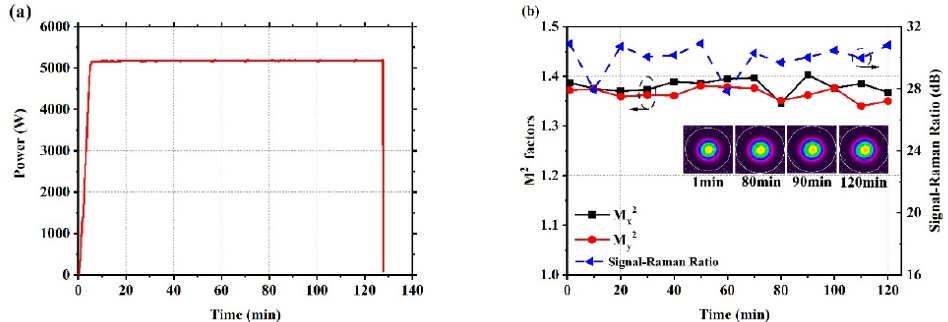
Figure 4. Output performance of stability test. ( a ) Output power. ( b ) M 2 factors with beam profile (inset).